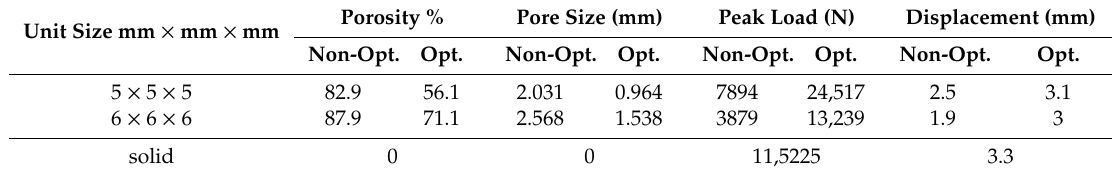
Table 6. Results of experimental work.